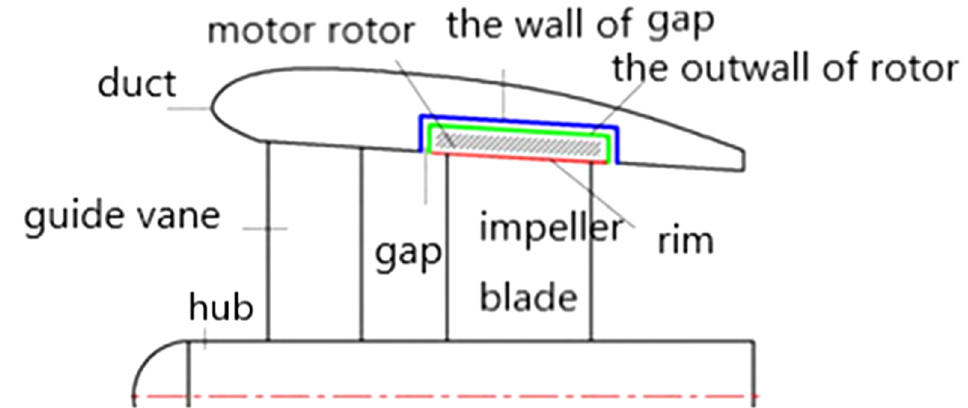
Figure 4. Schematic diagram of integrated motor pump-jet thruster.